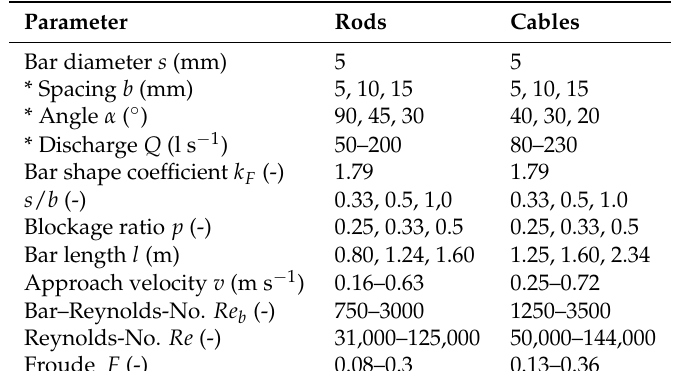
Table 1. Overview of the parameter—varied ones are marked with a *.